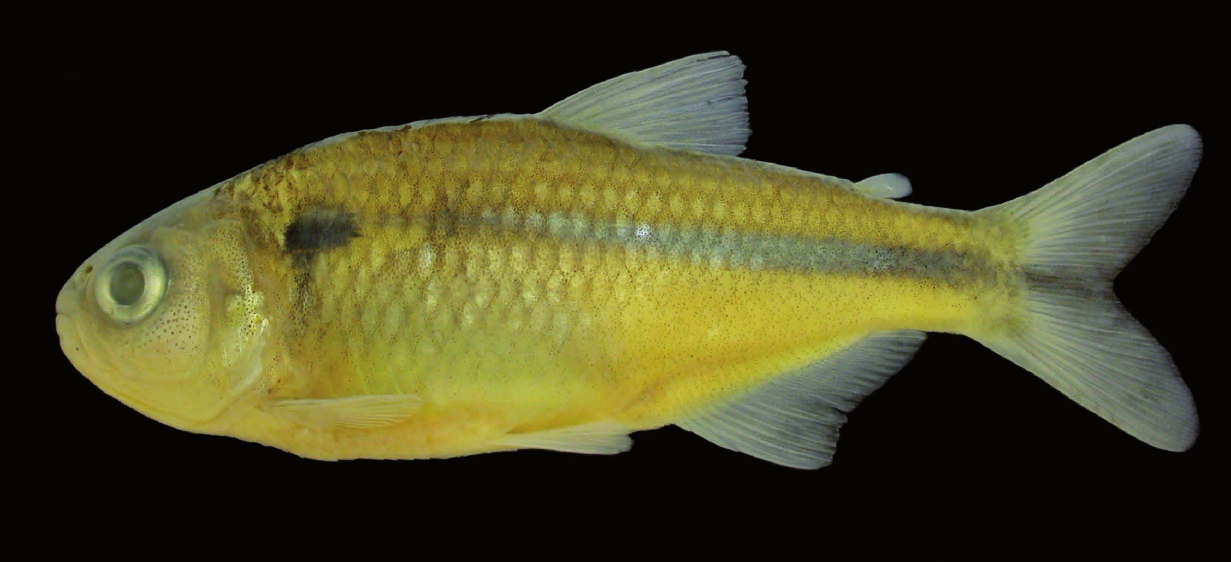
Fig. 7. Astyanax laticeps , MCP 35425, 61.2 mm SL, tributary of rio Ivaí, rio Jacuí drainage, Júlio de Castilhos, Rio Grande do Sul,